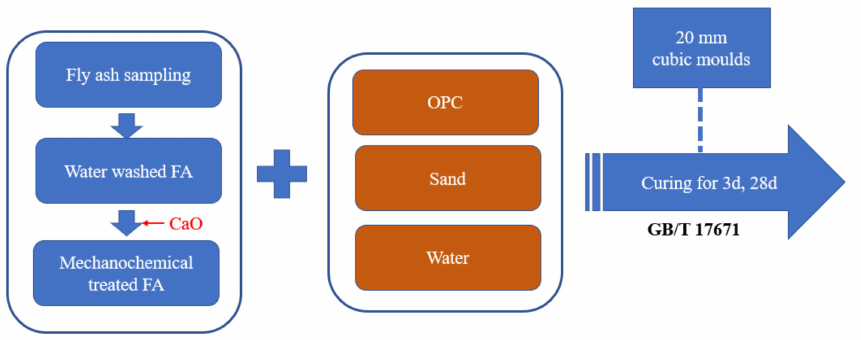
Figure 1. The schematic of the experiment